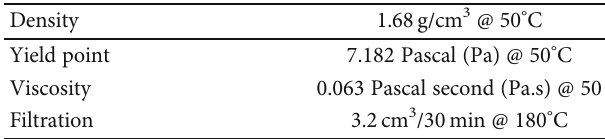
Table 7: OBM mud